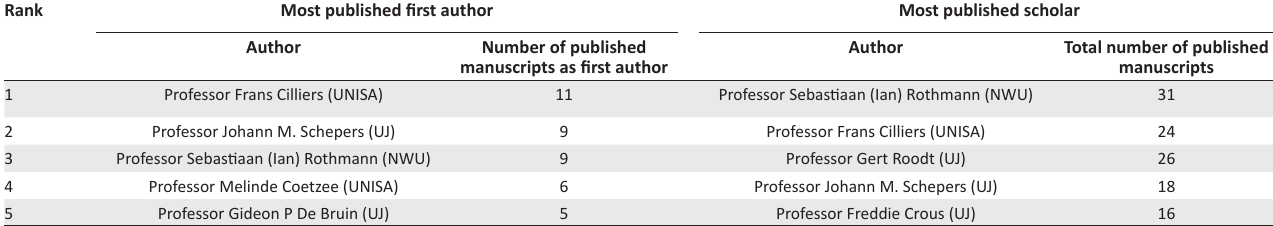
TABLE 3: Most published scholars.